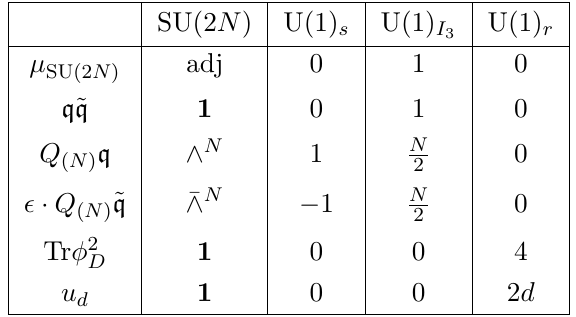
Table 4 . Charges of the gauge invariant operators of the dual theory of